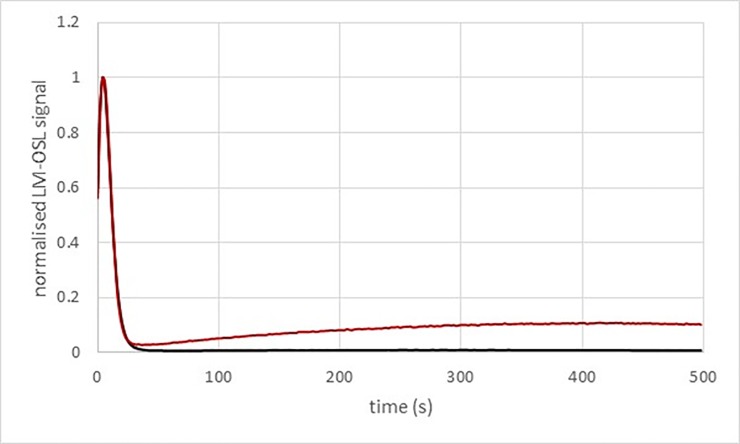
LM-OSL measurement of the BRS3 and BRS4 quartz samples (grey lines) and of the Risø calibration quartz (red lines) known to be dominated by a fast component signal.The inset shows the first 50 s of the measurements.